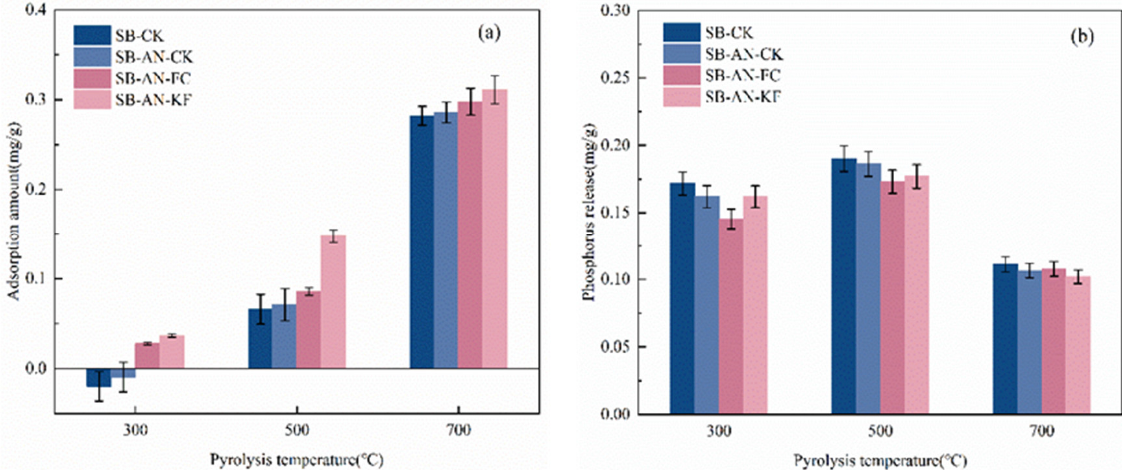
Figure 1. Phosphate uptake ( a ) and release ( b ) of sludge biochar pyrolyzed at 300, 500, and 700 °C.